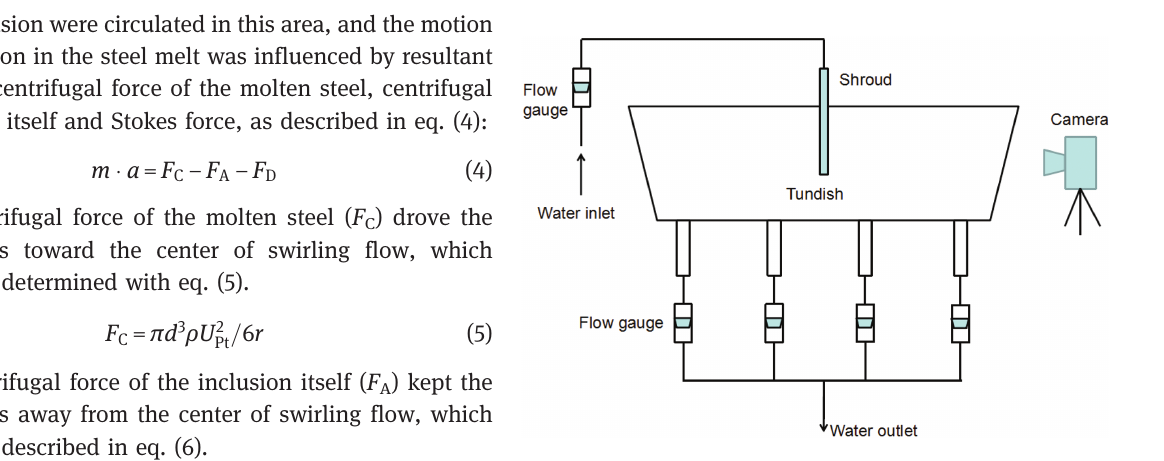
Figure 3: The schematic of water